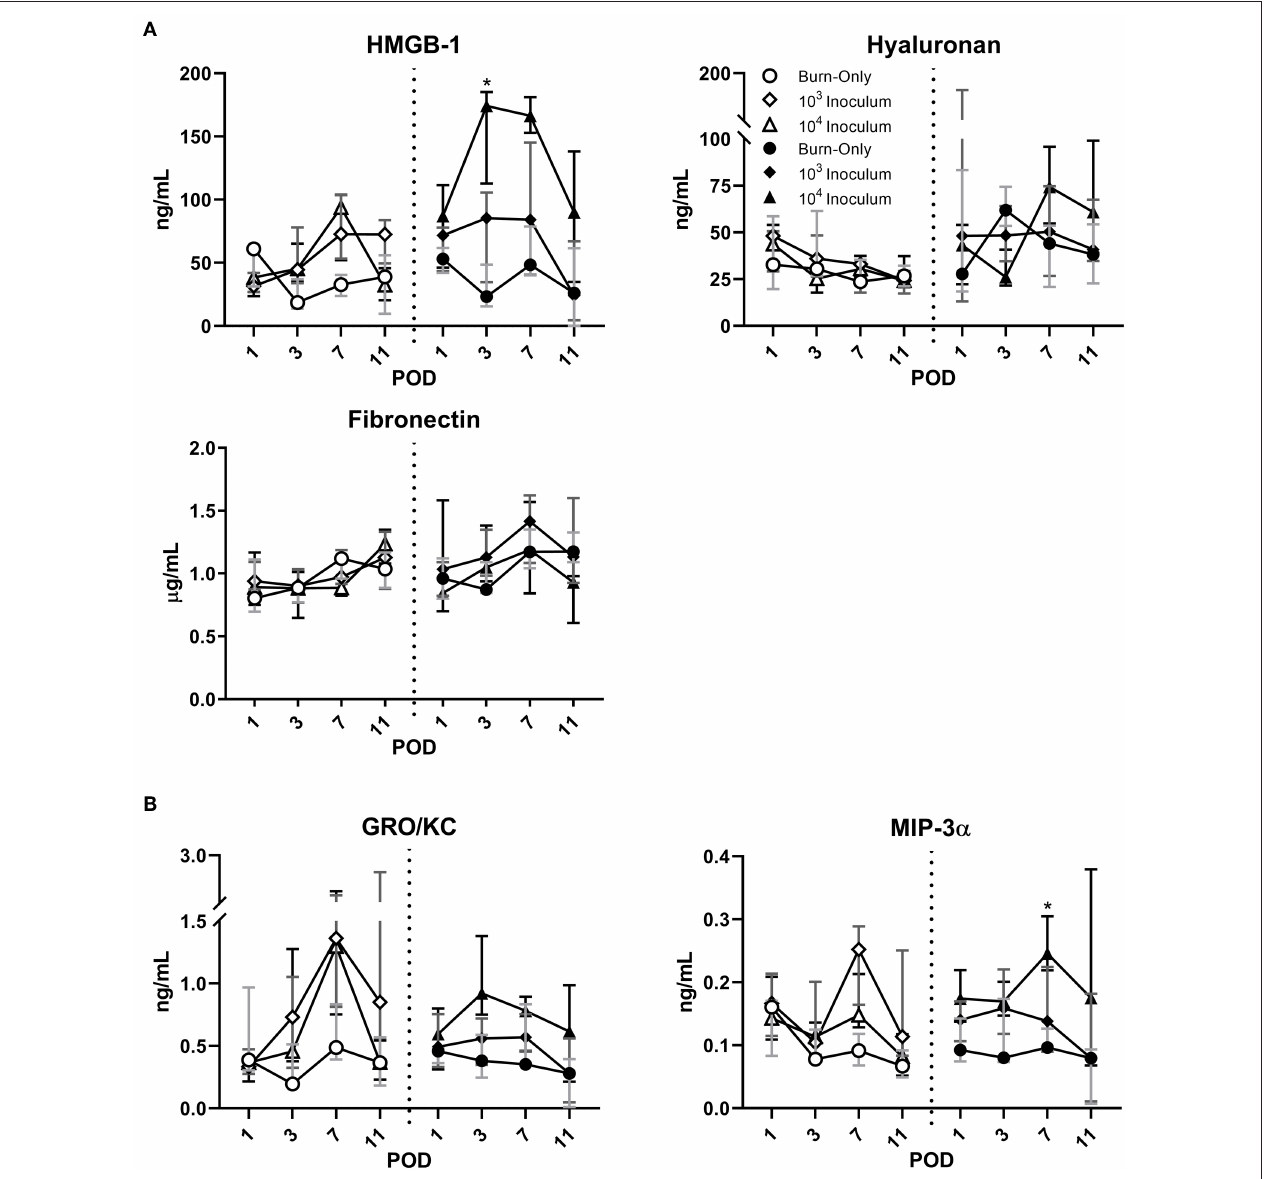
FIGURE 4 | P. aeruginosa infection results in dynamic changes to circulating DAMPs (A) and chemokines (B) . HMGB-1 was elevated by DPT and FT burn injury at POD 1, but remained close to sham levels thereafter in the burn-only group. P. aeruginosa resulted in increased release of HMGB-1, particularly in FT burn wounds at most PODs. Extracellular matrix proteins, HYL and FBN, appeared to follow similar trends between all groups. Infection with P. aeruginosa may cause potential decreases in FBN, which were noted in both infected groups of FT by POD 11. While burn-only groups showed minimal changes in circulating chemokines, GRO-KC and MIP-3 α were both elevated in the case of P. aeruginosa infection. Gray, dark gray, and black bars represent the interquartile ranges of burn-only, 10 3 inoculum, and 10 4 inoculum,